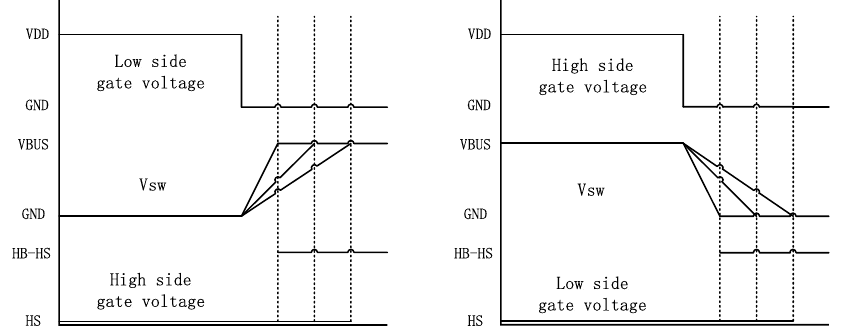
Figure 2. Ideal switching conditions.